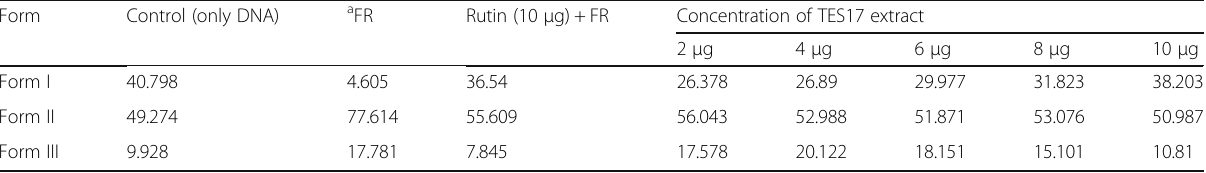
Table 6 Densitometric analysis of different forms of DNA (in percentage) after treatment with varying concentrations of TES17 extract